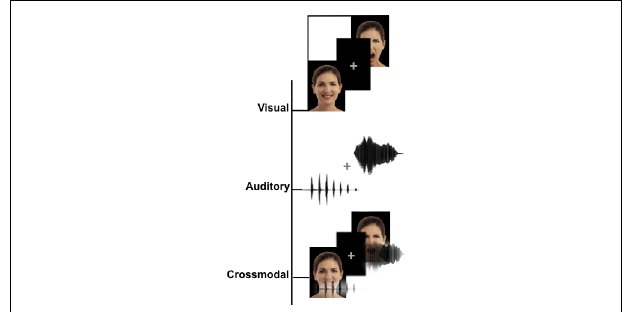
FIGURE 1 | Schematic representation of the stimuli. Examples of the stimuli for the three different modalities, including visual (facial expressions), auditory (non-verbal affective vocalizations) and crossmodal stimuli (congruent facial and vocal emotions presented